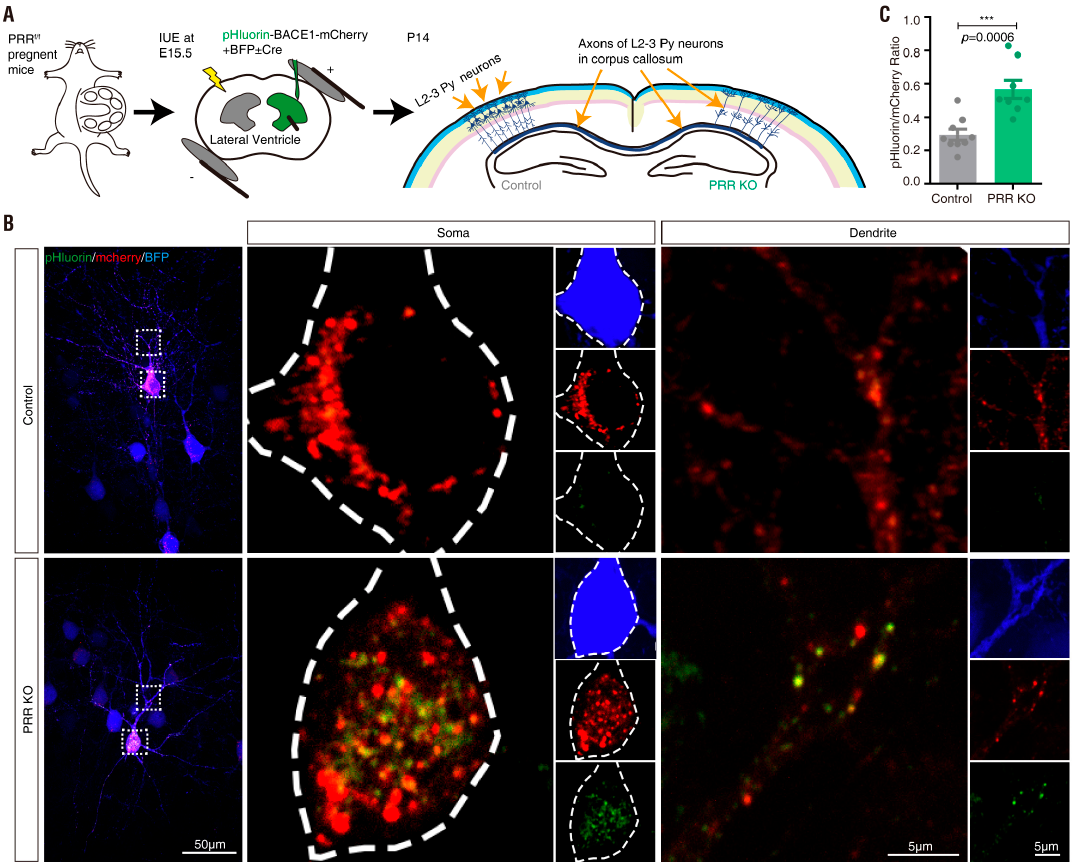
Figure 9. PRR regulation of pHluorin ‐ BACE1 ‐ mCherry and BACE1 activity in vivo ( A ) Schematics of in utero electroporation experimental procedures. PRR f/f embryos were in utero electroporated with plasmids of pHluorin ‐ BACE1 ‐ mCherry and BFP (control) or pHluorin ‐ BACE1 ‐ mCherry, BFP and Cre (PRR KO) at E15.5. The neocortical brain sections were collected at P14. ( B ) Representative Z ‐ stack projection images from neocortical brain sections was shown. Scale bar, 50 µm/5 µm. ( C ) Quantification analysis of the pHluorin/mCherry ratio from B. Data was shown as mean ± SEM ( n > 30 neurons from three independent experiments. Significance was calculated with Student’s t ‐ test; *** p < 0.001.